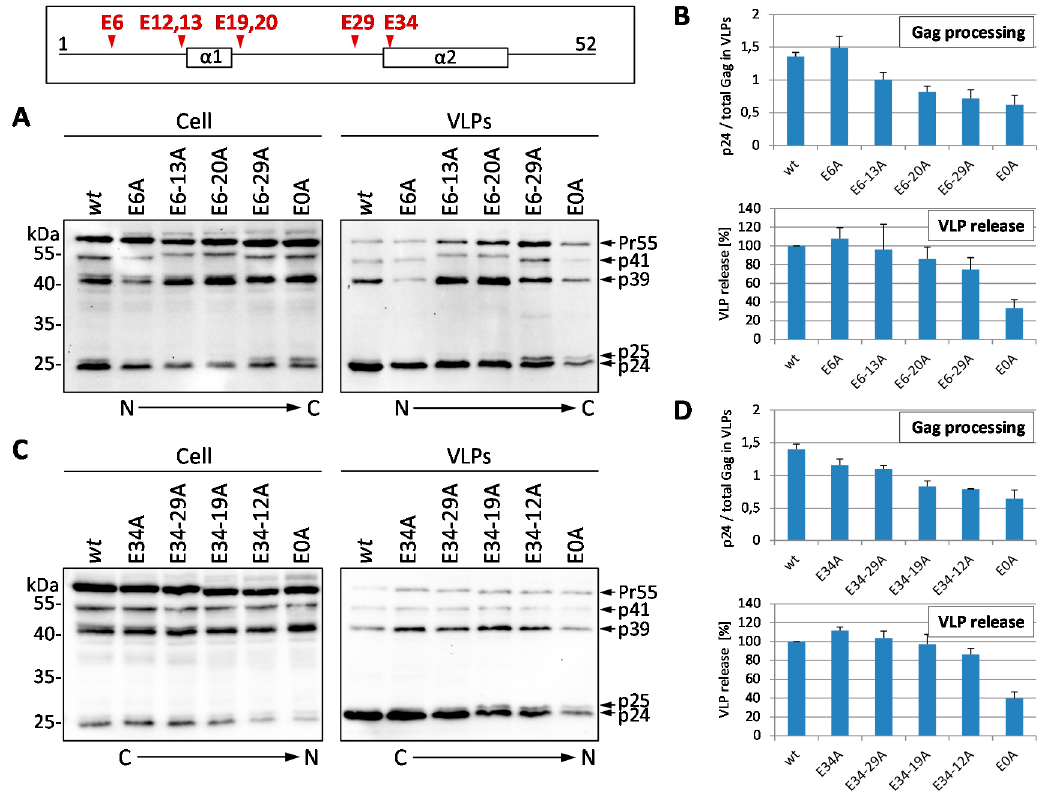
Figure 2. Successive mutation of glutamic acids in p6 leads to a dose-dependent defect in Gag processing and impaired VLP release. ( A , C ) HeLa cells were transiently transfected with the HIV-1 expression plasmid pNL env 1, coding either for the wt or mutants carrying Glu to Ala mutations, either from the N- ( A ) or from the C-terminus ( C ) of p6. Whole cell lysates and VLP fractions were analyzed by western blotting using anti -CA antibodies ( B , D ). The VLP release was calculated as the amount of CA in the VLP fraction relative to the total amount of Gag detected in cell and VLP fractions. Values on the y -axis were adjusted to 100% for wt . Rate of Gag processing was calculated as the amount of CA relative to the total amount of Gag in each VLP fraction. Resulting ratios were normalized by mean of all values of each experiment (adapted from [53]). Values on the y -axis represent arbitrary units. Bars represent the mean values of 3 independent experiments ± SD.